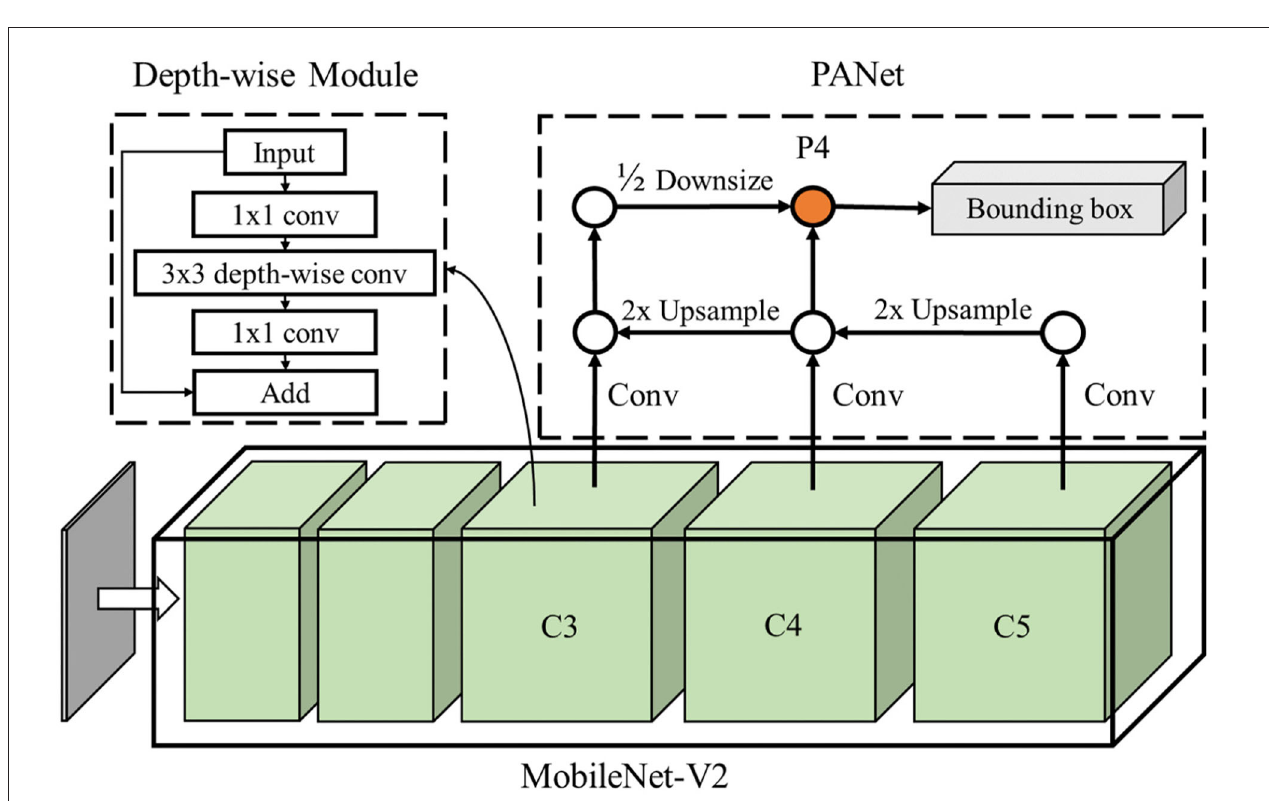
FIGURE 4 | Network architecture of the detector, Mobile-Citrus, which includes MobileNet-V2 as the backbone and PANet as the detection branch. The output of the objects’ bounding boxes are predicted from P4 level.